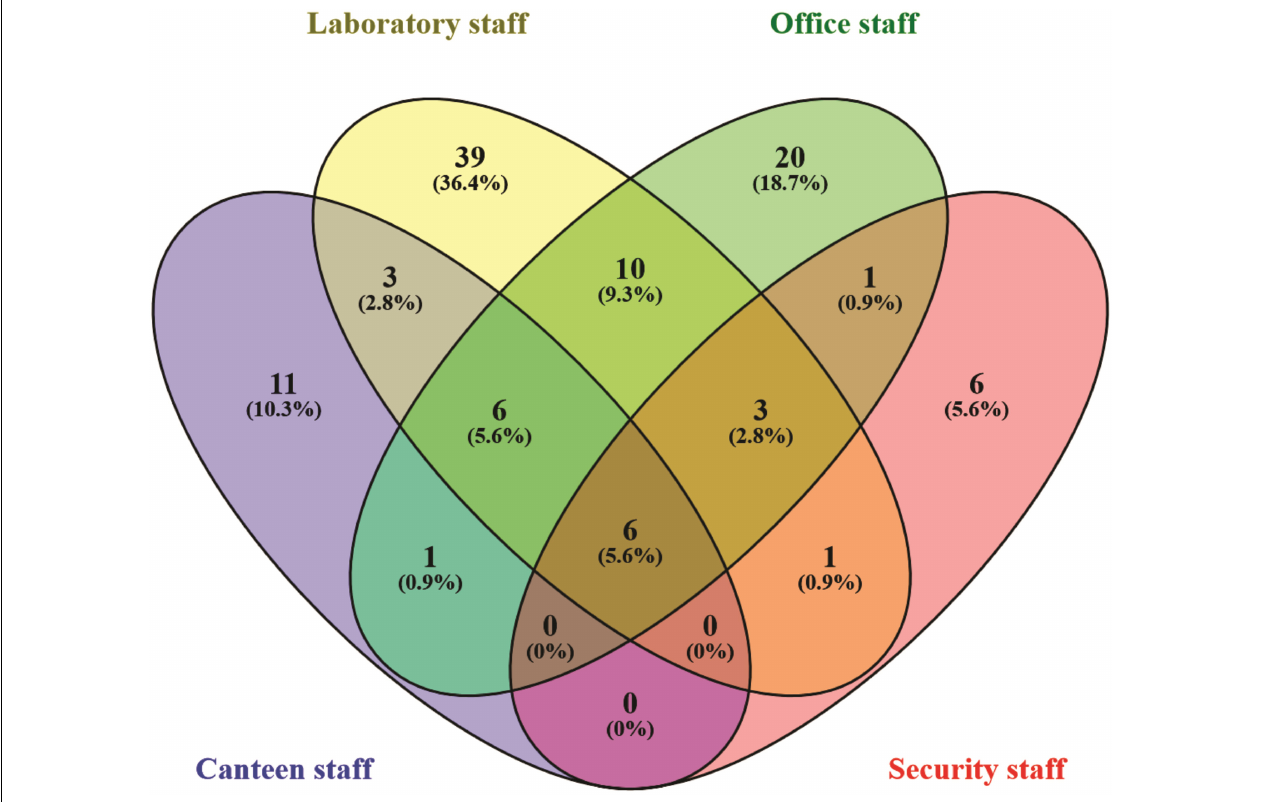
FIGURE 5 | Venn diagram exhibiting the microbial species shared and unique to the individuals working in different